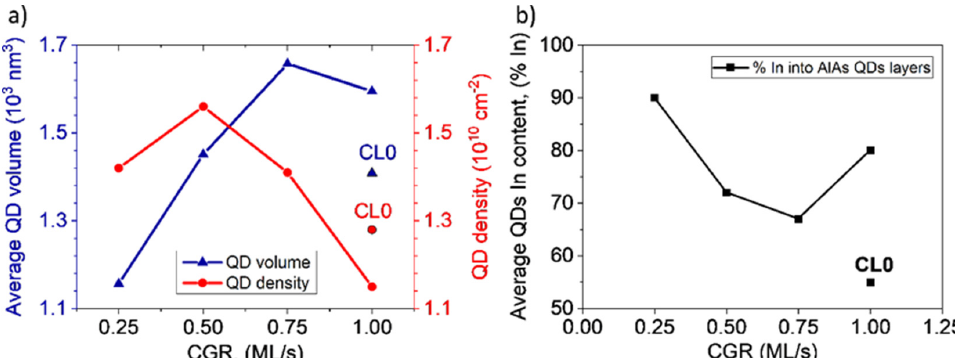
Figure 5. ( a ) Average QD volume (left axis) and superficial density (right axis) versus CGR ( b ) Average In content obtained for the different layers. Better protection of dots is seen for extreme AlAs CGR.